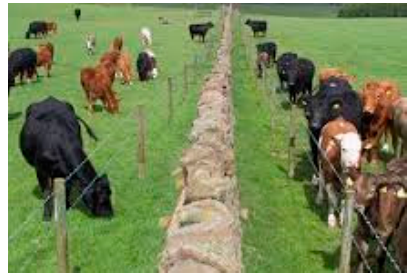
Figure 2. BLV positive and negative cattle separated by two fences.